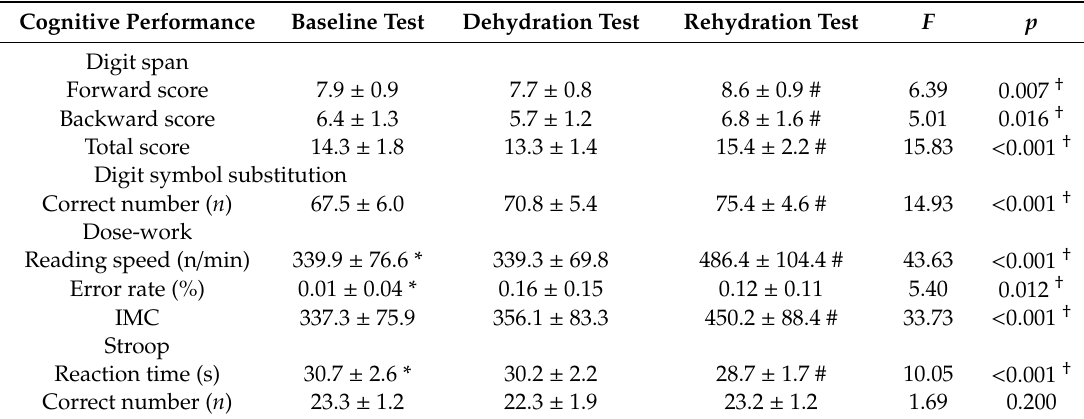
Table 4. Cognitive performance of